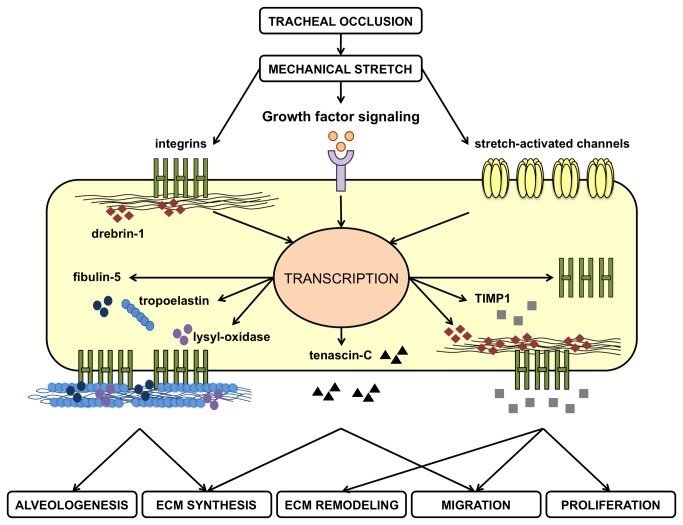
Synopsis of hypothetical mechanisms by which alveolarization-relevant genes related to the extracellular matrix (ECM) might be modulated by a sustained mechanical stretch induced by tracheal occlusion.Tissue stretch is transmitted to alveolar myofibroblasts directly by mechanoreceptors (integrins) and ion channels or indirectly by liberation of growth factors stored/secreted in the ECM. Subsequent activation of intracellular signalings leads to increased transcription of target genes linked to the ECM and involved in elastogenesis (tropoelastin, lysyl-oxidase, fibulin-5, integrins), cytoskeletal rearrangements and cell migration (integrins, drebrin1, tenascin-C), ECM remodeling (tissue inhibitor of matrix metalloproteinase-1, TIMP1) or cell proliferation (TIMP1).